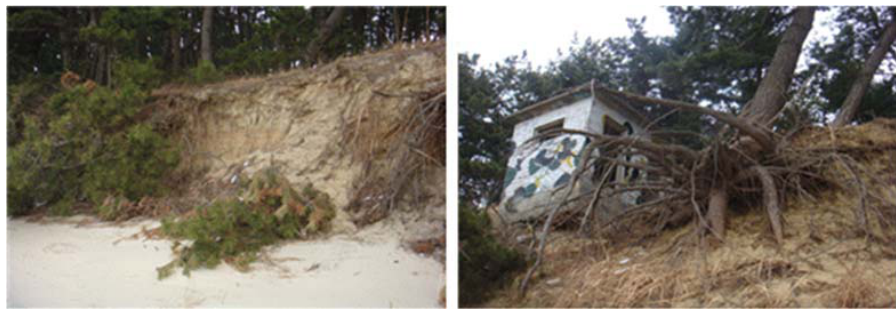
Figure 2. Coastal erosion situation in Janghang Songrim Beach (Jan. 2014).